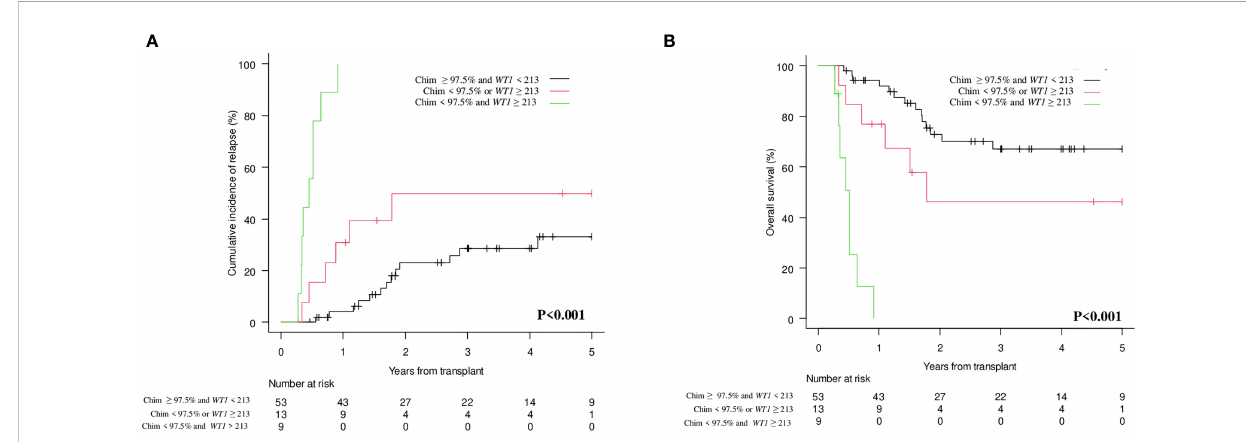
FIGURE 4 Cumulative Incidence of Relapse (CIR) and Overall Survival (OS) according to combination of molecular chimerism on CD34+ cells and WT1 levels at 3rd month. (A) CIR at 1 year CD34+ ≥ 97.5% and WT1 < 213 copies/ABL1×10^4 vs CD34+ <97.5% WT1 ≥ 213 copies/ABL1×10^4 vs CD34+ <97.5% or WT1 ≥ 213 copies/ABL1×10^4: 4.1% (95% CI 0.8-12.4) vs 30.7% (95% CI 9.5-55.4) vs 100% (95% CI NA). (B) OS at 1 year CD34+ ≥ 97.5% and WT1 < 213 copies/ABL1×10^4 vs CD34+ <97.5% or WT1 ≥ 213 copies/ABL1×10^4 vs CD34+ <97.5% and WT1 ≥ 213 copies/ABL1×10^4: 94.2% (95% CI 83.0- 98.1) vs 76.9% (95% CI 44.91.9)] vs 0% (95% CI